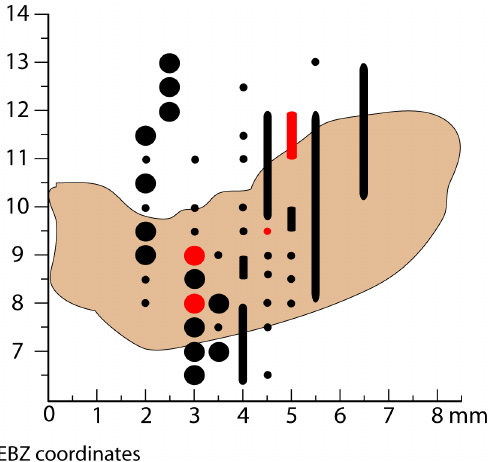
Figure 6. Distribution of stimulation sites in the VTA/SN. Outline of VTA/SN from all AP levels projected onto a single AP plane. The origins of the remaining axes are relative to ear bar zero (EBZ, see description in [25]). Black circles represent all stimulation sites where no dopamine release was observed. Red circles represent all stimulation sites where dopamine release was recorded. Small circles indicate stimulation currents # 300 m A. Large circles indicate application of a . 300 m A, typically 400 m A current. The vertical columns represent a series of stimulation sites along the rostral-caudal axis separated by less than 250 m m. In these columns, color and size codes remain the